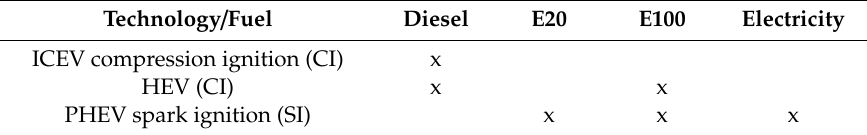
Table 1. Matrix for TTW energy consumption and emissions